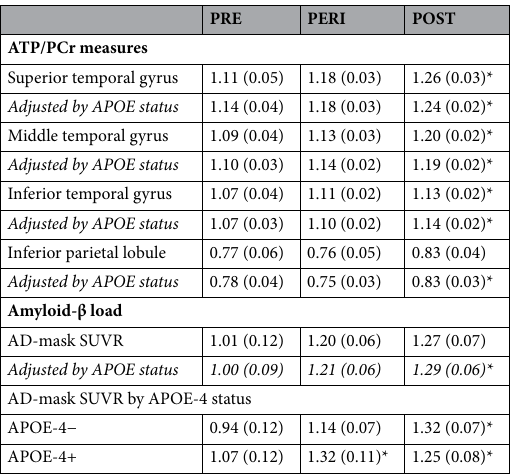
Table 2. Region-of-Interest (ROI) measures by menopausal stage group. APOE-4−, APOE-4 non-carriers; APOE-4+, APOE-4 carriers; PERI, peri-menopausal group; POST, post-menopausal group; PRE, pre-